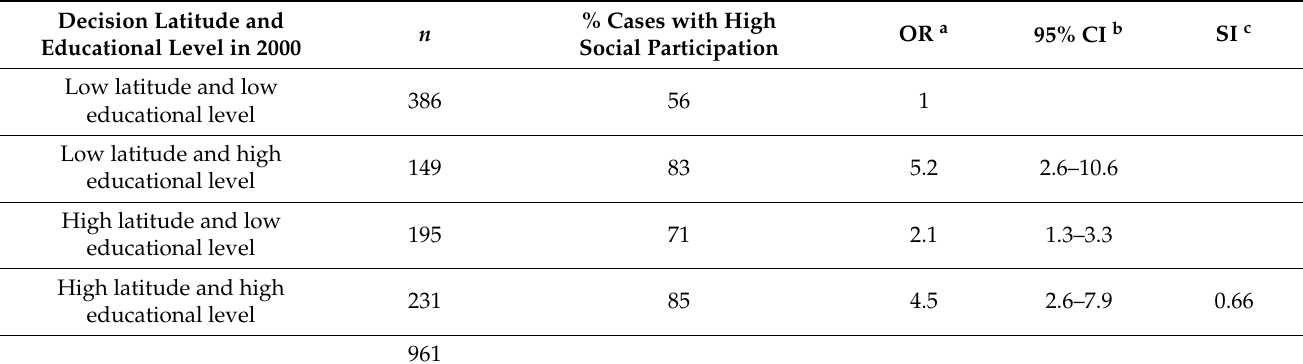
Table 6. Interaction analyses with synergy index, regarding latitude at work and level of education, both measured at baseline in 1999 and social participation in 2010. Scania Public Health Cohort, n =